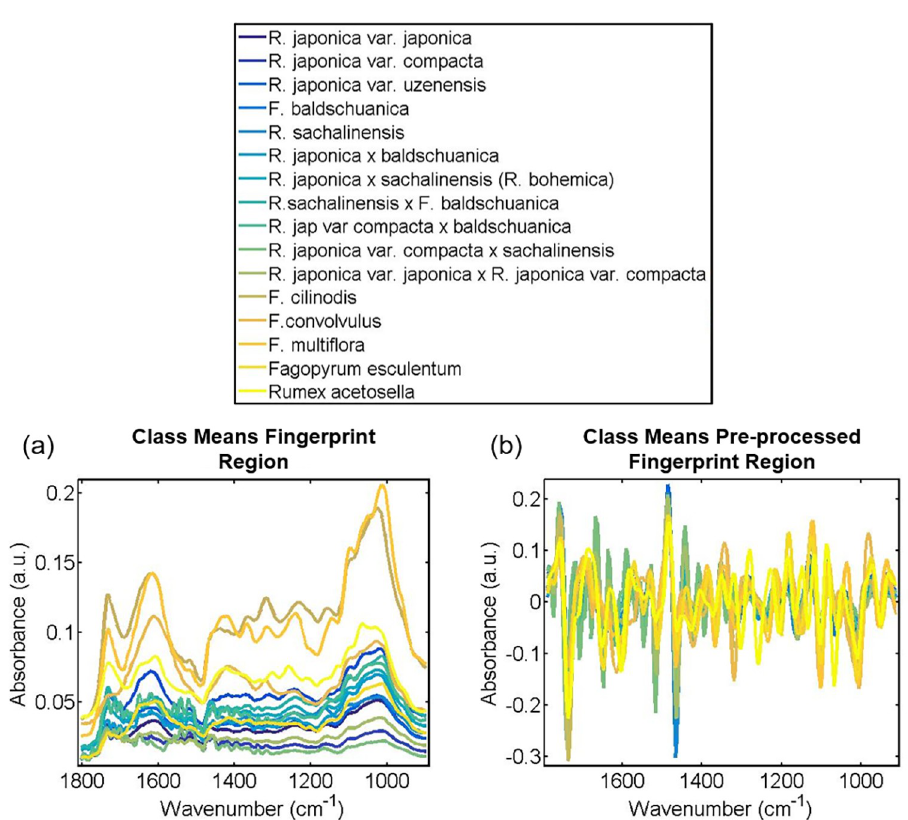
Fig 1. (a) Raw and (b) pre-processed class means IR-spectra for fingerprint region grouped by species. The pre- processing used for part (b) was Savitzky-Golay (SG) second differentiation followed by vector